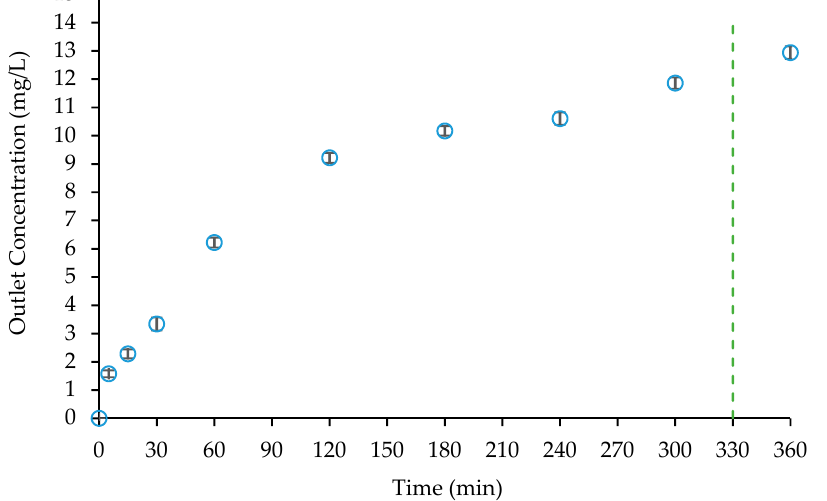
Figure 13. Breakthrough curve for nitrate removal in MBC column at feed flowrate of 2 mL / min and influent concentration of 15 mg / L. Table 5. MBC bed characterisation for NO 3 − at feed flowrate of 2 mL / min and influent concentration of 15 mg / L.